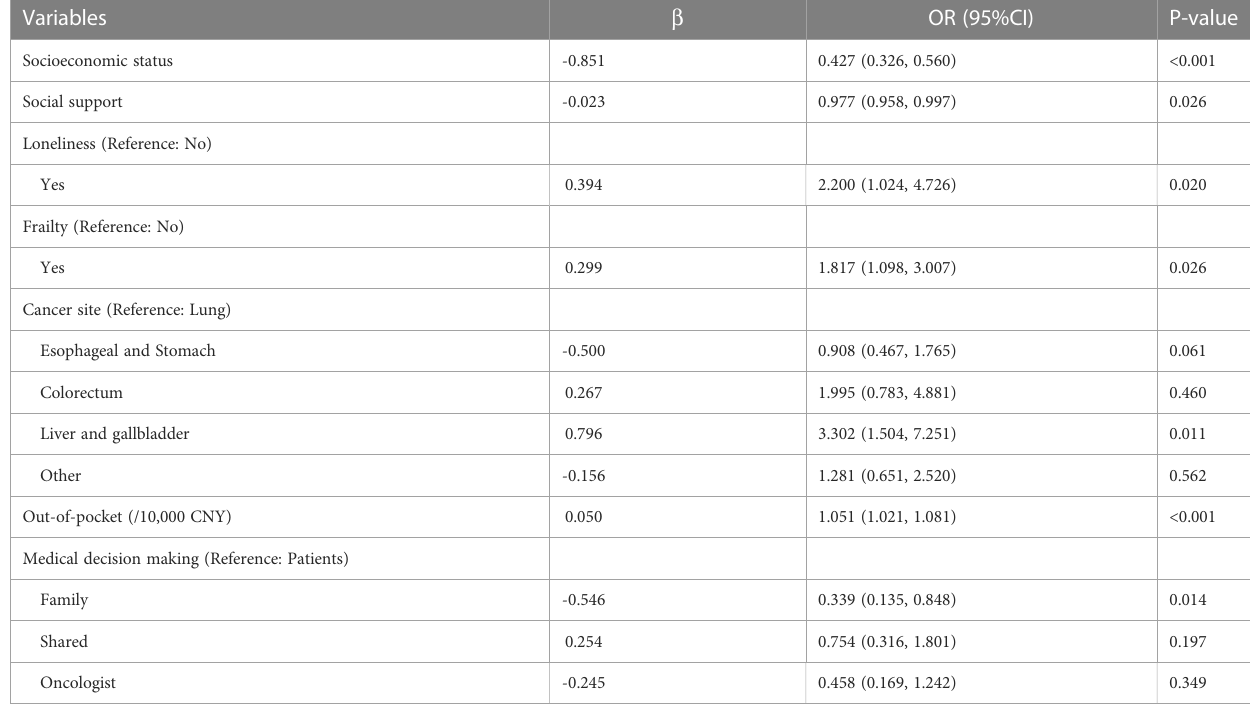
TABLE 4 Results of Logistic regression analysis (Reference: Lower fi nancial hardship).